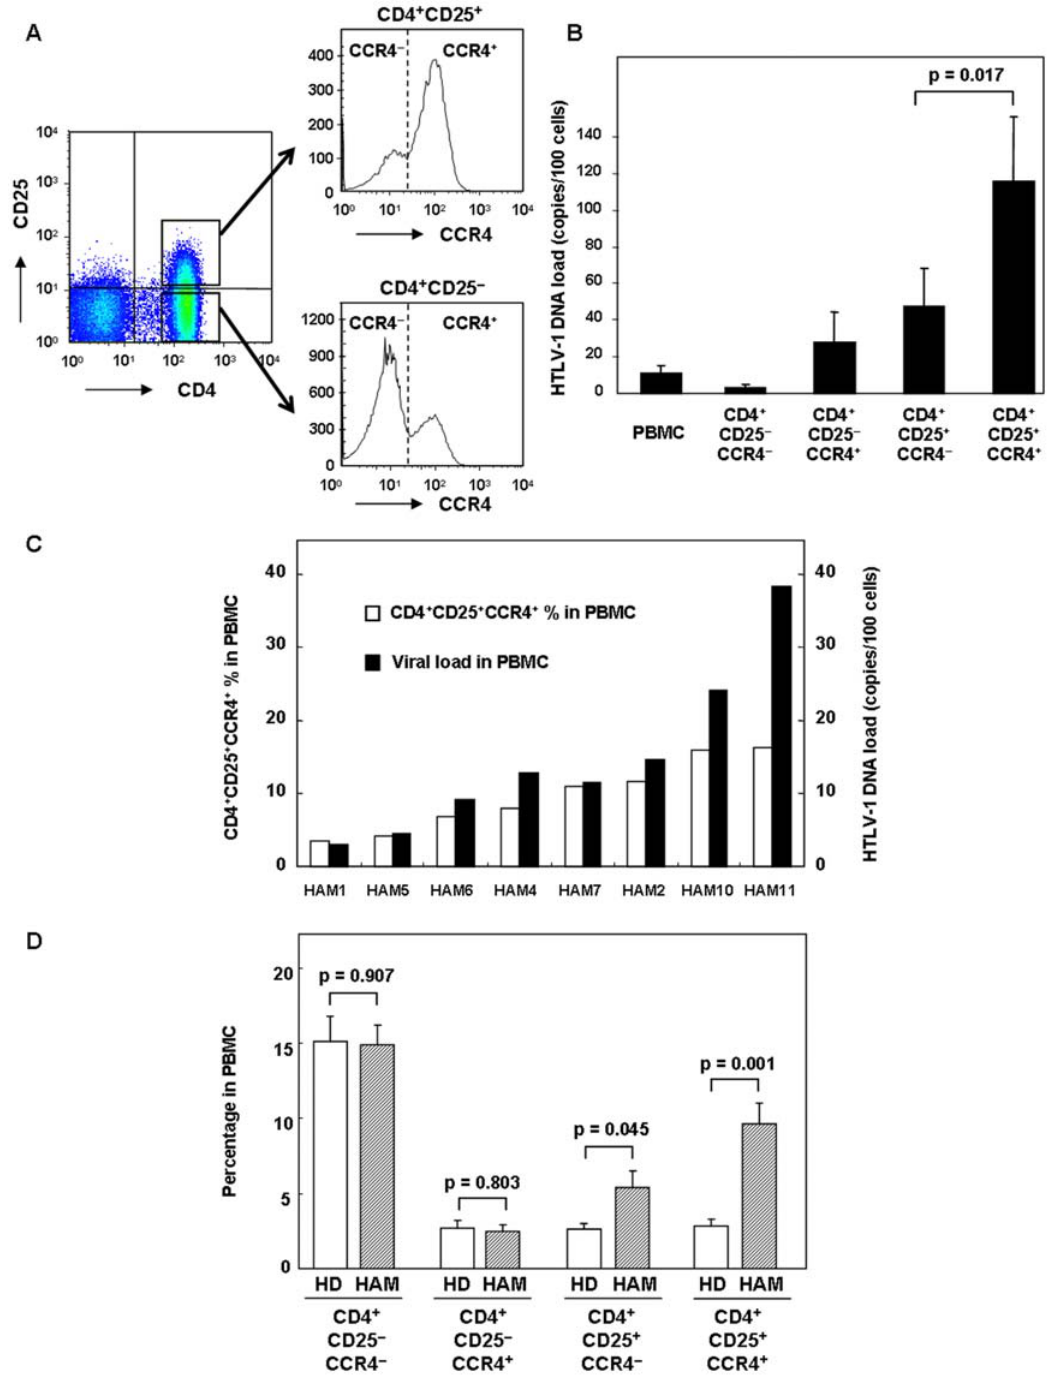
Figure 1. CD4 + CD25 + CCR4 + T cells are the main reservoir for HTLV-1 and are present in increased levels in HAM/TSP patients. A. Representative plot of FACS sorting. CD4 + CD25 2 CCR4 2 , CD4 + CD25 2 CCR4 + , CD4 + CD25 + CCR4 2 , and CD4 + CD25 + CCR4 + T cells were separated by FACS. The purity of each cell population was approximately 99% (Figure S1). B. HTLV-1 proviral DNA load of PBMCs and CD4 + CD25 2 CCR4 2 , CD4 + CD25 2 CCR4 + , CD4 + CD25 + CCR4 2 , and CD4 + CD25 + CCR4 + T cells were assessed using quantitative PCR in 8 HAM/TSP patients. Data are presented as mean 6 SE. The HTLV-1 proviral load was significantly higher in the CD4 + CD25 + CCR4 + T cells than in the CD4 + CD25 + CCR4 2 T cells (p=0.017 by the Wilcoxon signed-rank test). C. HTLV-1 proviral DNA load in PBMCs and the percentages of CD4 + CD25 + CCR4 + T cells in the PBMCs of 8 HAM/TSP patients. D. The frequency of CD4 + CD25 2 CCR4 2 , CD4 + CD25 2 CCR4 + , CD4 + CD25 + CCR4 2 , and CD4 + CD25 + CCR4 + T cells in HDs and HAM/TSP patients. The frequency of CD4 + CD25 2 CCR4 2 , CD4 + CD25 2 CCR4 + , CD4 + CD25 + CCR4 2 , and CD4 + CD25 + CCR4 + T cells in 8 HDs and 11 HAM/TSP patients was analyzed by FACS and represented as the frequency of each cell population. Data are presented as mean 6 SE. The P value was calculated by unpaired Student’s t test.